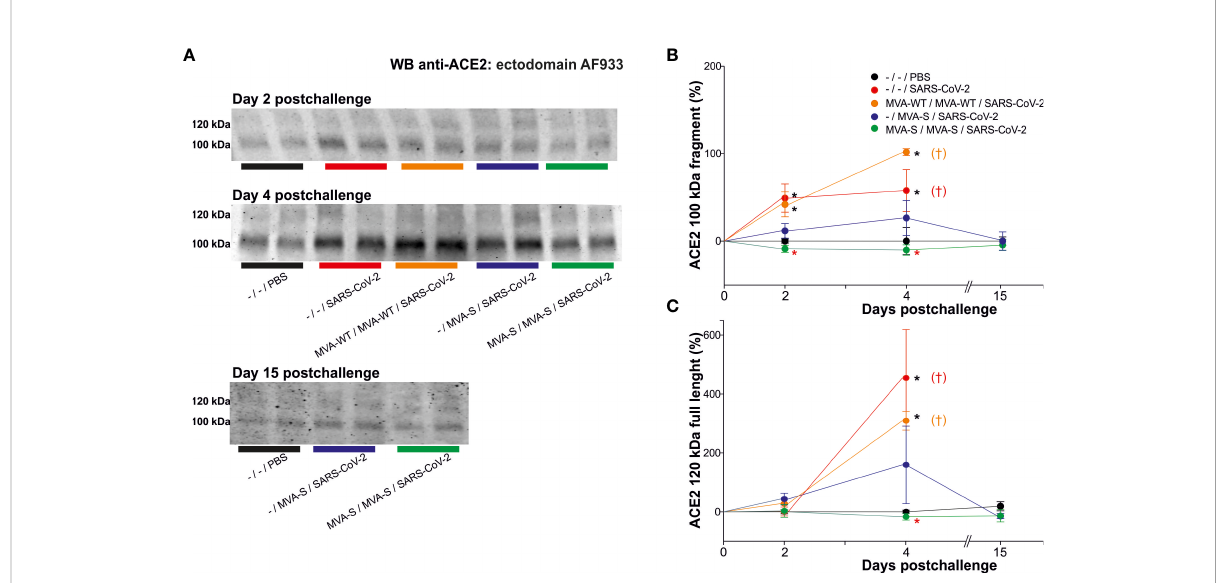
FIGURE 2 MVA-CoV2-S vaccine candidate prevented serum ACE2 changes. K18-hACE2 transgenic mice (n= 11/group) were immunized by the intramuscular route with one or two doses of 1×10 7 PFUs of MVA-CoV2-S (also termed MVA-S) at weeks 0 and 4. Then, at week 9, mice were challenged intranasally with a lethal dose of SARS-CoV-2 (MAD6 isolate; 1×10 5 PFUs). MVA-WT-inoculated and unvaccinated (-) mice (n= 11) were also intranasally challenged with SARS-CoV-2. Unvaccinated and unchallenged mice (n= 9) were used as a negative control (PBS). At days 2 (n= 3/group), 4 (n= 3/group), and 15 (n= 5) serum was collected. (A) Representative ACE2 immunoblots for samples at indicated situation resolved with the ectodomain AF933 antibody. Densitometric quanti fi ed for the cleaved 100 kDa fragment (B) and for the full-length 120 kDa ACE2 species (C) . All samples were analyzed at least in duplicate in separate blots. † : All mice inoculated with MVA-WT or unvaccinated and infected were sacri fi ced at 6 days post-challenge. Signi fi cant p values ( p < 0.05) respect to unvaccinated and unchallenged mice (*; -/-/PBS), or respect to unvaccinated and challenged mice (*;